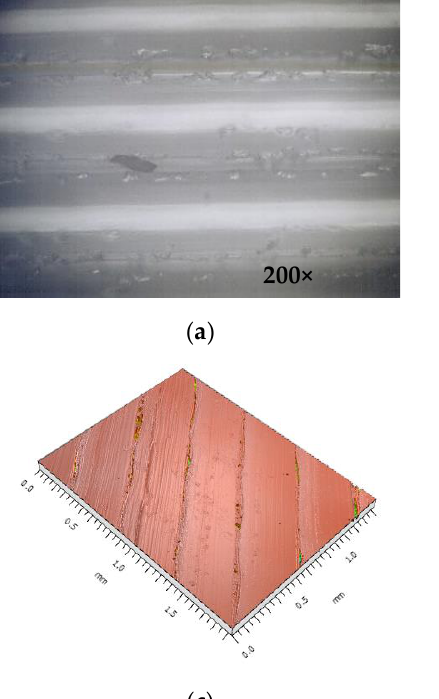
Figure 20. Surface analysis: ( a , c ) PLA, blue ink, colour distribution 33%, infill 15%; ( b , d ) PLA+, green ink, colour distribution 33%, infill 15%.